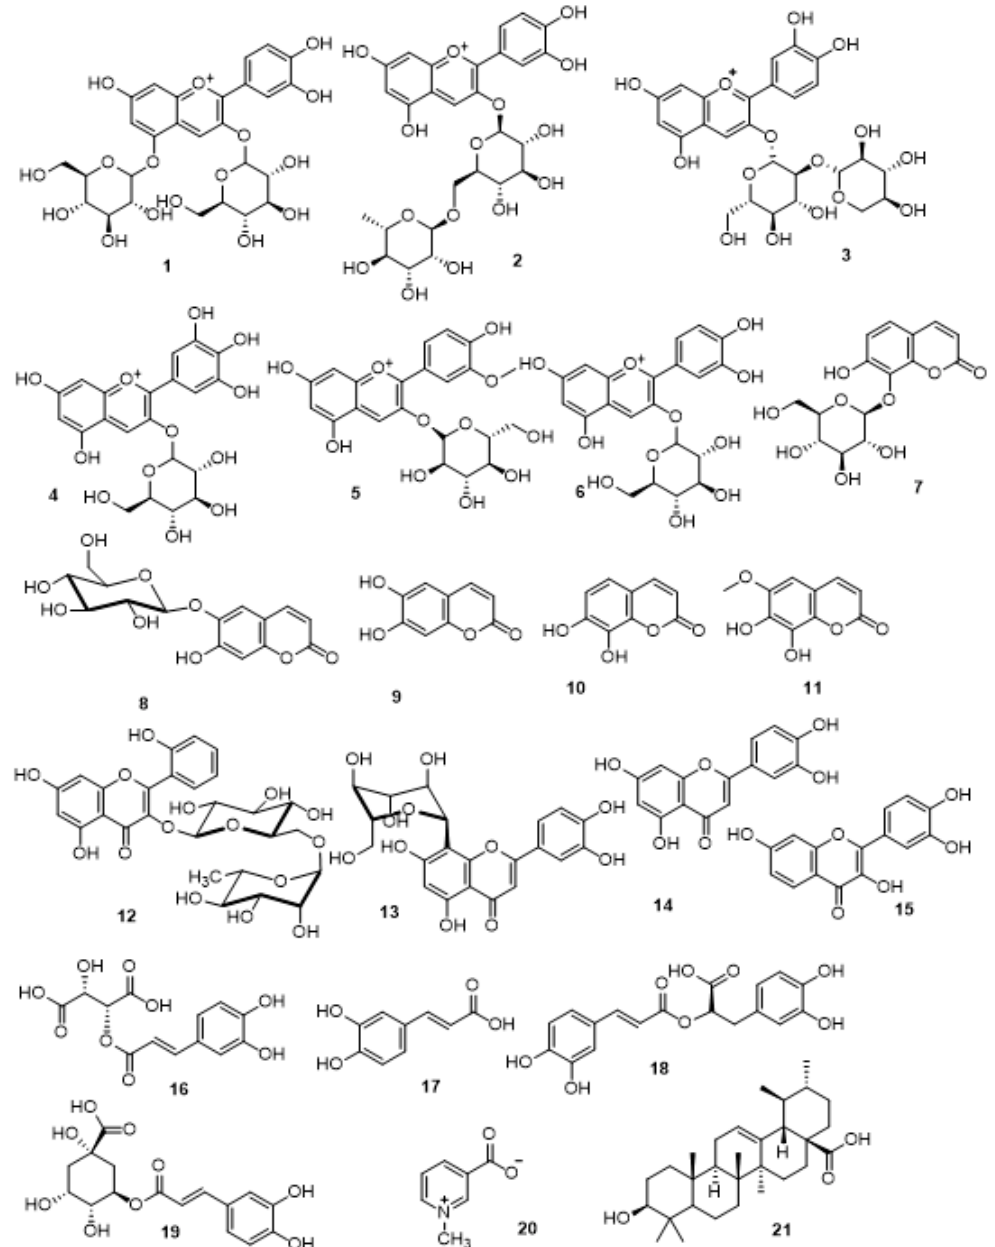
Figure 1. Structures of the detected metabolites as listed in Table 1.